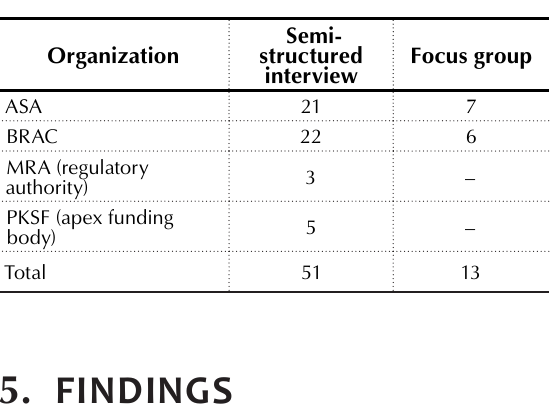
Table 1. Metho ds of data